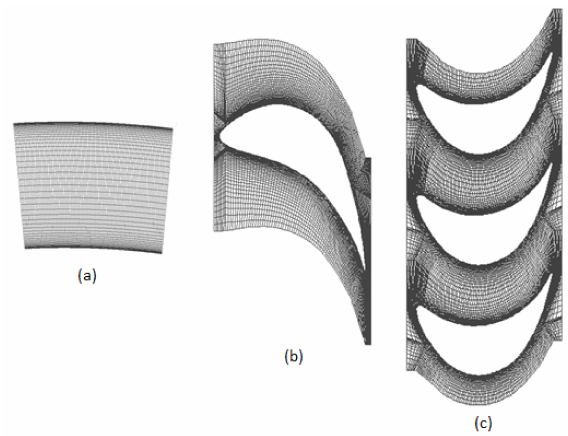
Figure 6. Mesh distribution for 8M cells. ( a ) radial distribution ( b ) stator vane distribution ( c ) rotor vane distribution.